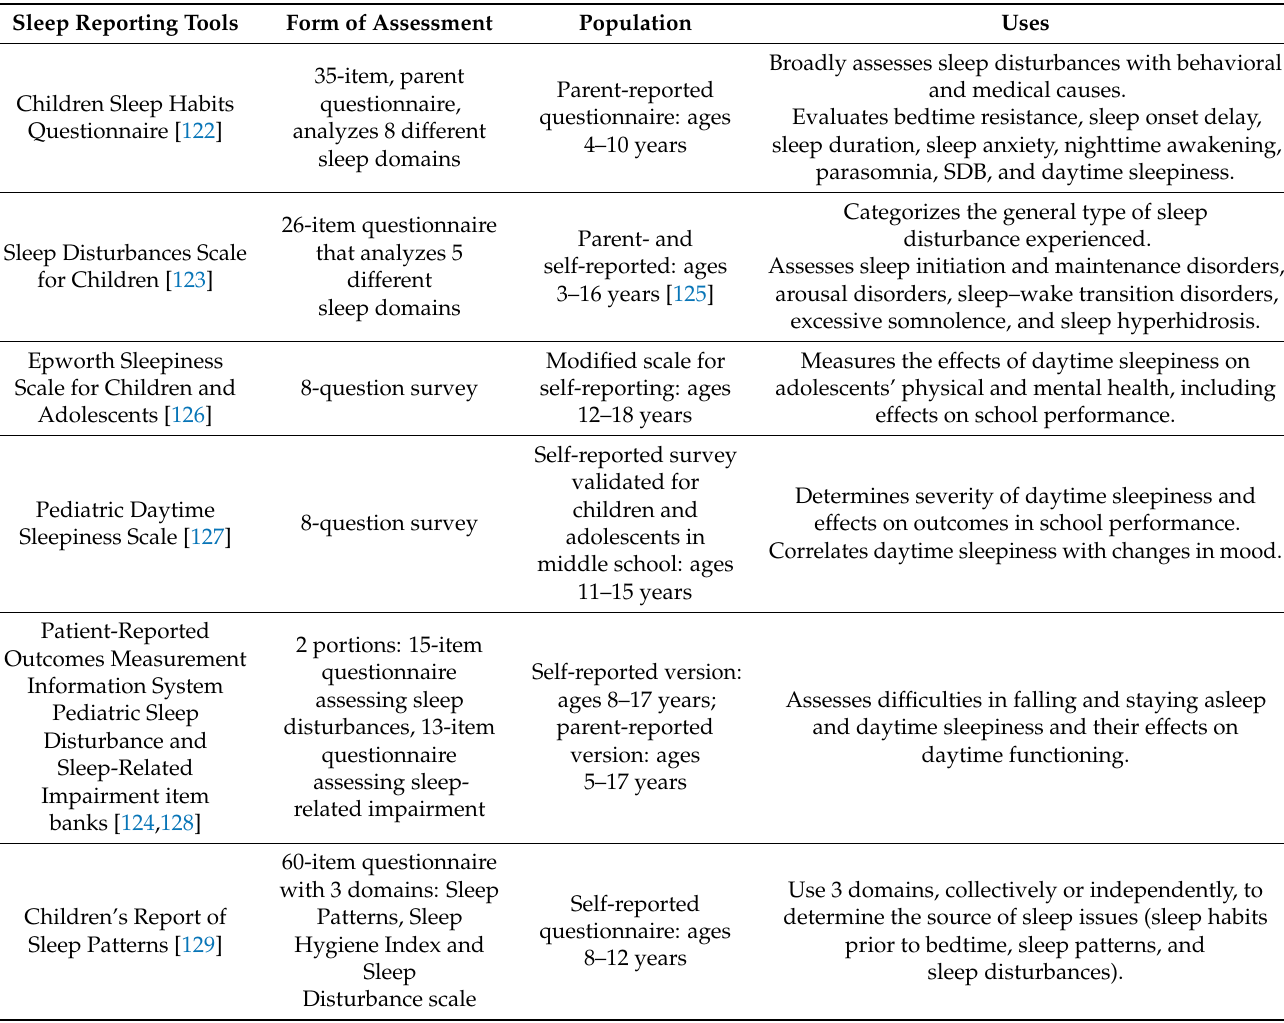
Table 1. Summary of selected sleep-reporting tools and their utility in assessing sleep disturbances. Sleep Reporting